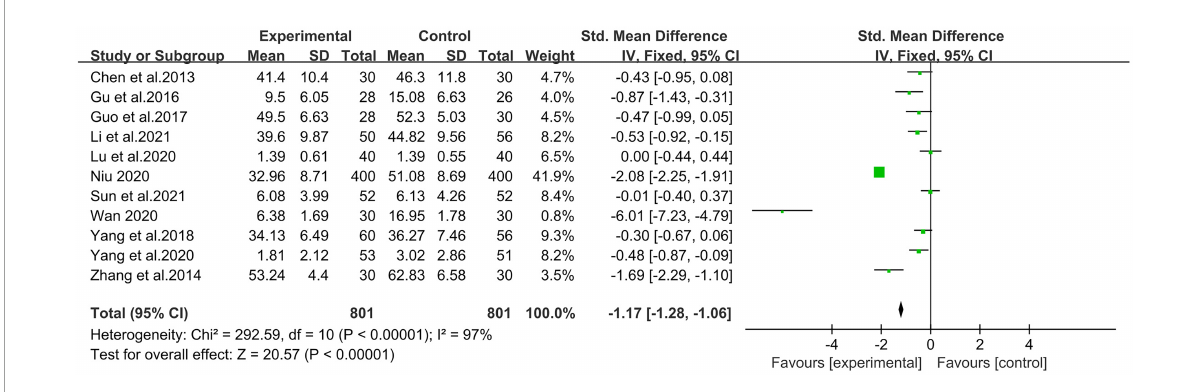
FIGURE3 Forest plot of total effects of mindfulness-based intervention on anxiety of Chinese college students.